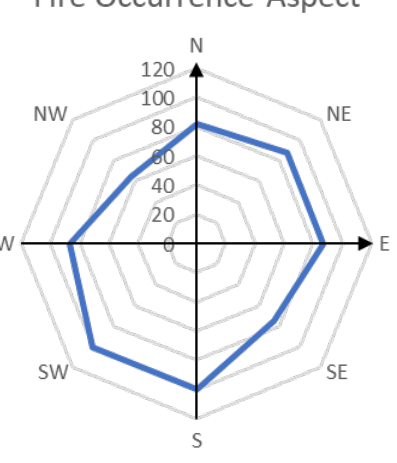
Figure 11. Fire-occurrence aspect account.